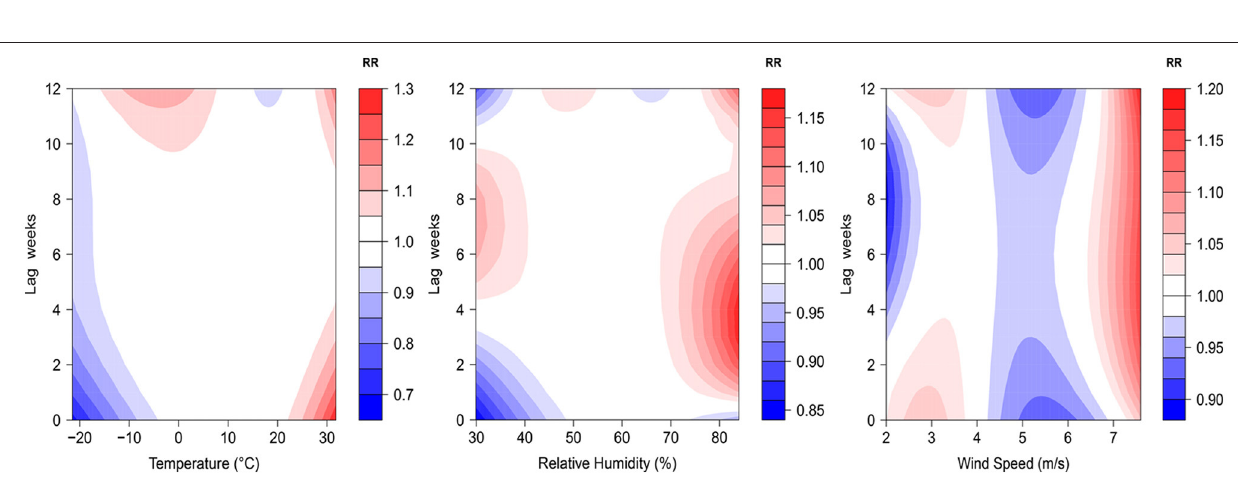
FIGURE 2 | Contour plots of relative risks of meteorological factors on PTB at 0–12 lag weeks. The median value was